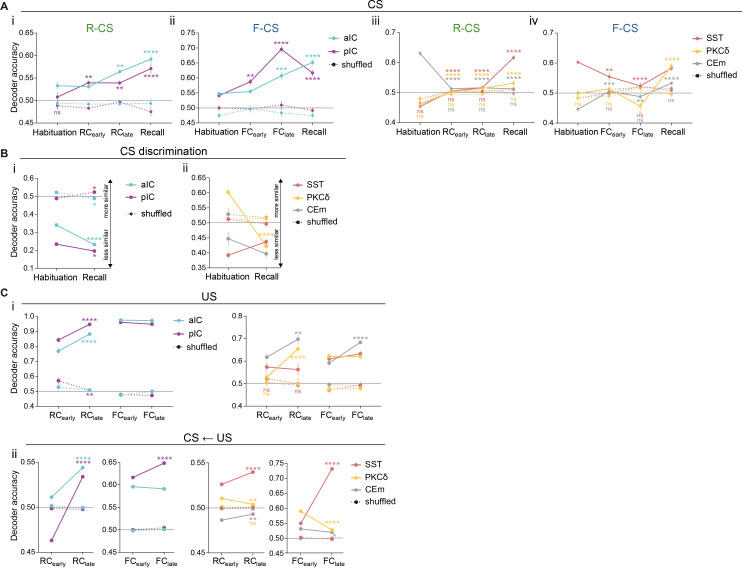
Valence-specific mapping of CS and US features in IC–CE circuitry.(A) Decoder accuracy (Da) of an MLP trained to detect CS information in the activity of 200 random draws of 40 neurons per IC subregion for (i) R-CS (significant stage x subregion interaction in a two-way ANOVA, F9,3184=5.68, p<0.0001) and (ii) F-CS (significant stage x subregion interaction in a two-way ANOVA, F9,3184=11.50, p<0.0001) and 200 random draws of CE neurons (30 for each CESST and CEPKCδ and seven for CEm) per stage upon (iii) R-CS (significant stage x population interaction in a two-way ANOVA, F15,4776=29.17, p<0.0001) and (iv) F-CS (significant stage x population interaction in a two-way ANOVA, F15,4776=7.93, p<0.0001). * Indicate significant differences from the respective habituation stage within each subregion/population by a designated post hoc test. Only non-significant differences to shuffled data are explicitly indicated (‘ns’). (B) Alternative classification approach to Figure 1Cii, Dii for CS discrimination. An MLP was trained to discriminate between preCS, R-CS, and F-CS. Graphs show average Da for classifying the correct CS, given the bin is within any CS period and was classified as such. (i) 200 random draws of 40 neurons each for aIC and pIC (significant stage x subregion interaction in a two-way ANOVA, F3,1592=18.53, p<0.0001) and (ii) of 30 neurons from CEPKCδ and CESST and 7 CEm neurons (significant stage x population interaction in a two-way ANOVA, F5,2366=15.58, p<0.0001). (C) (i) Da of an MLP trained to detect US information in the activity of 200 random draws of 40 neurons per IC subregion, 30 for CEPKCδ and CESST and 10 neurons for CEm for R-US (IC: significant stage x subregion interaction in a two-way ANOVA, F3,1592=16.06, p<0.0001; CE: significant stage x population interaction in a two-way ANOVA, F5,2228=5.40, p<0.0001) and F-US (IC: significant effect of subregion in a two-way ANOVA, F3,1592=1619.00, p<0.0001, CE: significant stage x population interaction in a two-way ANOVA, F5,2388=4.01, p=0.0013). This classifier was used for the CS←US task. (ii) Projection of US properties by application of the MLP from (i) to the respective CS (IC/RC: significant stage x subregion interaction in a two-way ANOVA, F9,3192=242.50, p<0.0001; IC/FC: significant stage x subregion interaction in a two-way ANOVA, F9,3192=9.97, p<0.0001; CE/RC: significant stage x population interaction in a two-way ANOVA, F5,4788=18.39, p<0.0001; CE/FC: significant stage x population interaction in a two-way ANOVA, F5,4788=603.30, p<0.0001). All data presented as mean ± SEM. Full statistical report in Appendix 1—table 1.